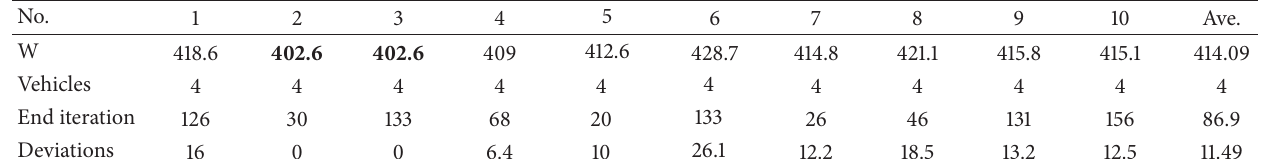
Table 10: The results of DNA-ant colony algorithm (moderate or high level pollution).